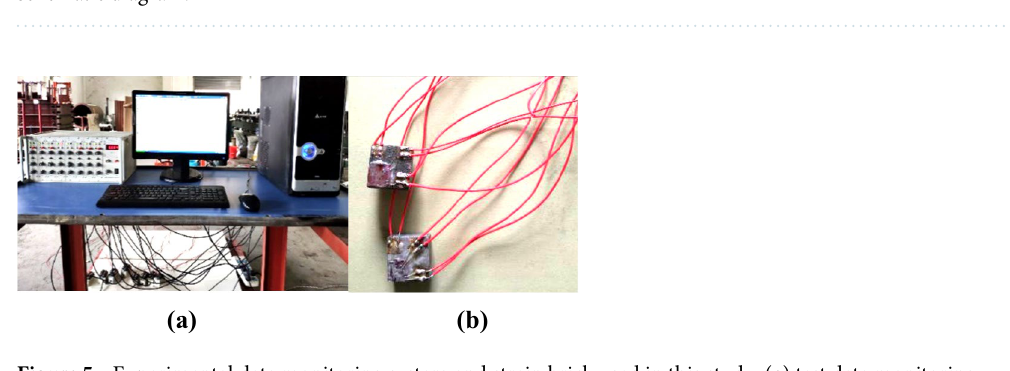
Figure 4. Schematic of the experimental blasting device used in this study: ( a ) device main view, and ( b ) 3-D schematic diagram.